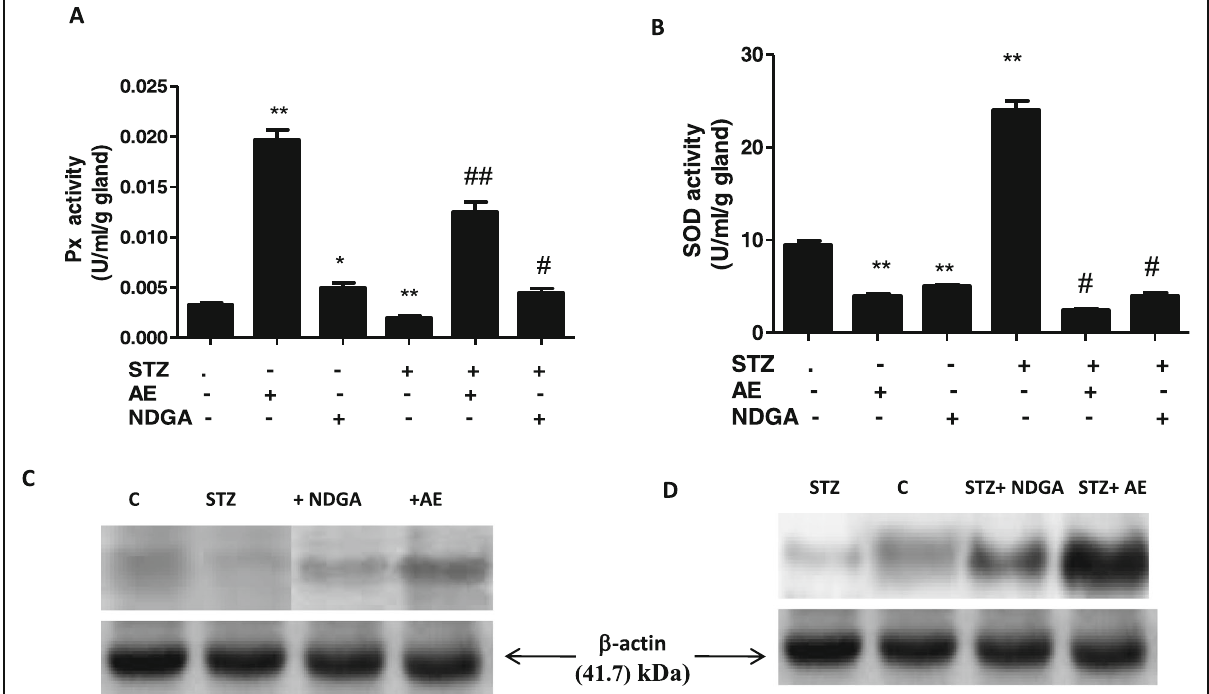
Fig. 5 Effect of AE and NDGA on antioxidant enzymes activity ( a and b ) and on antioxidant enzymes expression ( c and d ) in submandibular glands of STZ- treated rats. Western blots are representative of three experiments. Results represent Mean ± SEM of three determinations made in duplicate. * P < 0.05, ** P < 0.01 significant differences between submandibular glands from normal control and submandibular glands from STZ- treated animals. # P < 0.05, ##P < 0.01 significant differences between glands from STZ and STZ + AE or NDGA-treated glands (ANOVA+ Dunnett ’ s